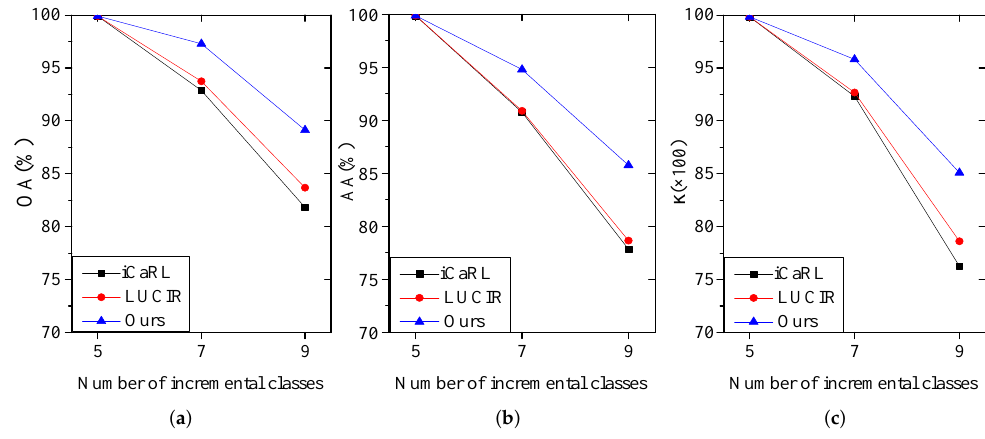
Figure 12. Comparison of classification results of different models, OA ( a ); AA ( b ); and κ ( c ).